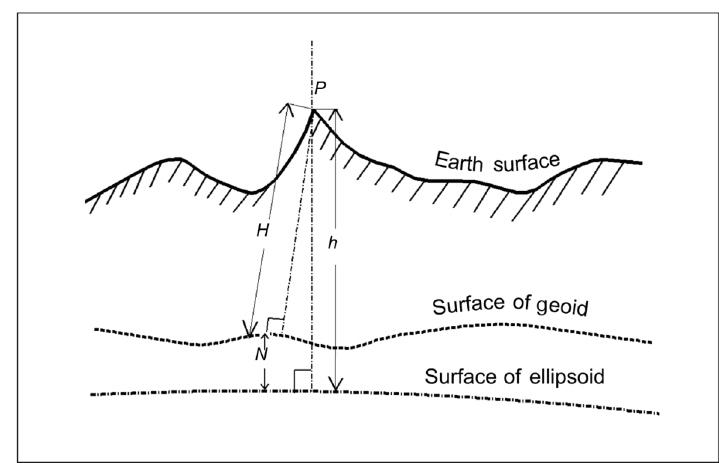
Fig. 1. The relationship between orthometric, geoid and ellipsoidal